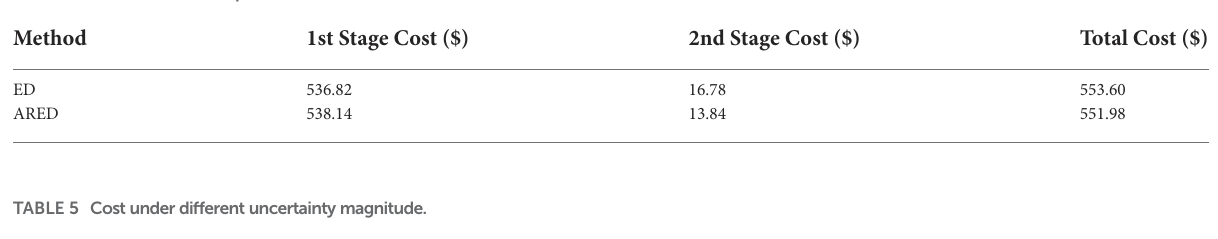
TABLE 4 Per-hourcostcomparisonofedandared.